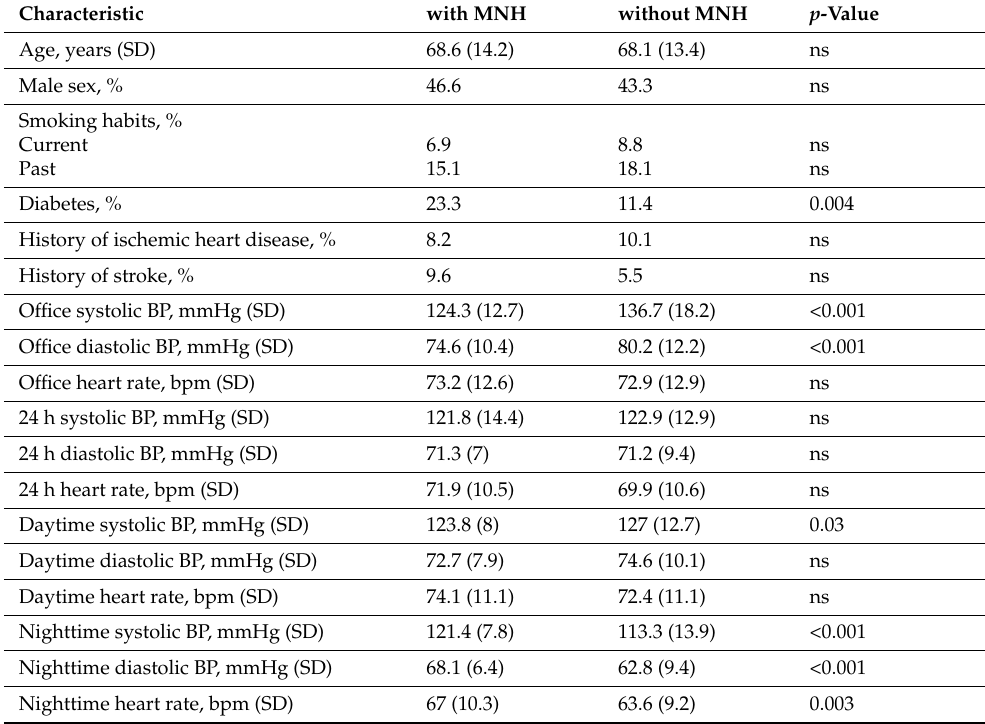
Table 8. Comparison between subjects with and without MNH among treated